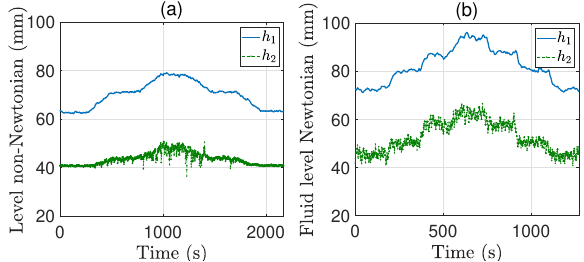
Figure 10: The change of bottom slope angle γ r due to vibrations during the experiments. γ is the expected value of the channel bottom slope angle. The bottom slope is S b = sin( γ ).